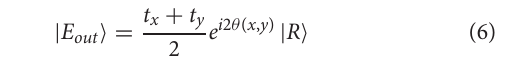
For a special case: t x circularly polarized light is incident, the outgoing beam will undergo full polarization